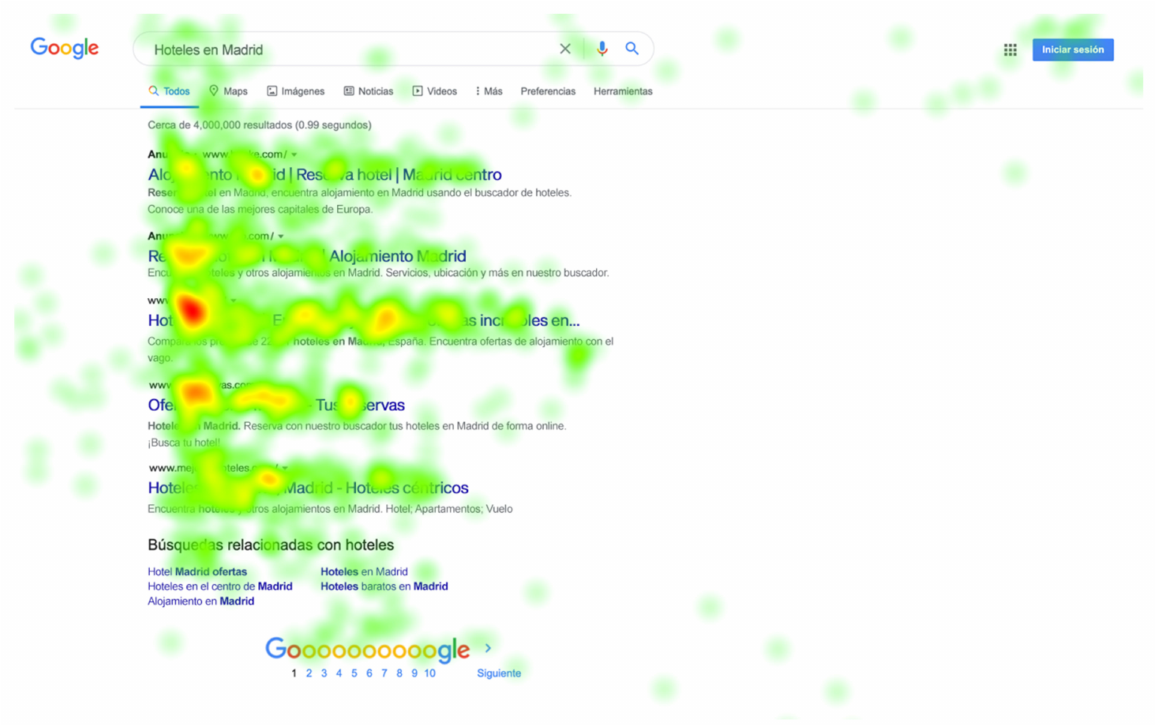
Figure 5. Heat map for the ASO